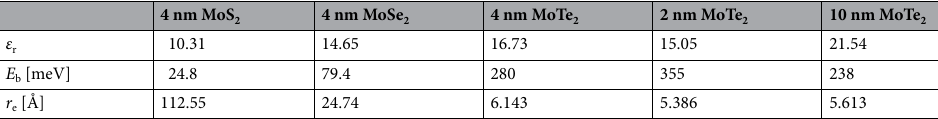
Table 2. Static dielectric constant, exciton binding energy, and exciton radius of multilayered 2H-MoX 2 at 8